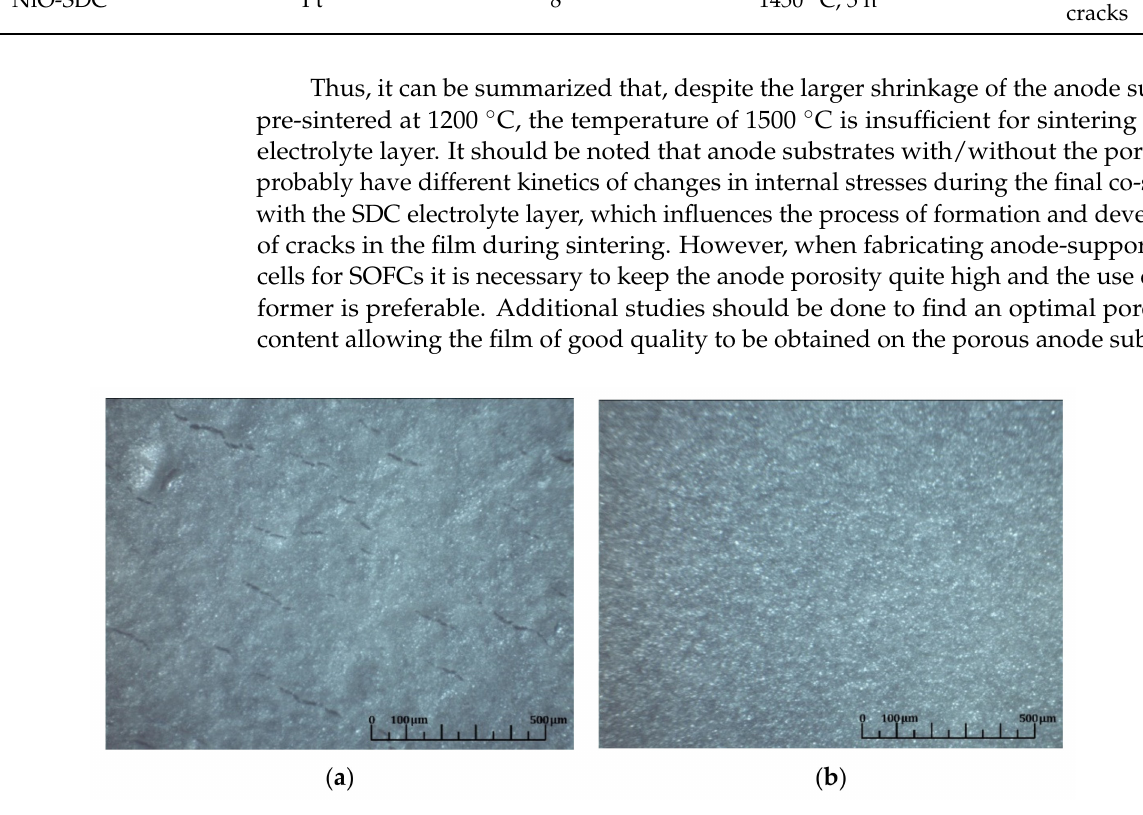
Figure 13. Optical images of the surface of the SDC films obtained after the final co-sintering: ( a ) at 1450 ◦ C, 5 h with the NiO-SDC substrate formed with the addition of 20 wt.% of graphite powder; ( b ) at 1500 ◦ C, 5 h with the NiO-SDC substrate without the pore